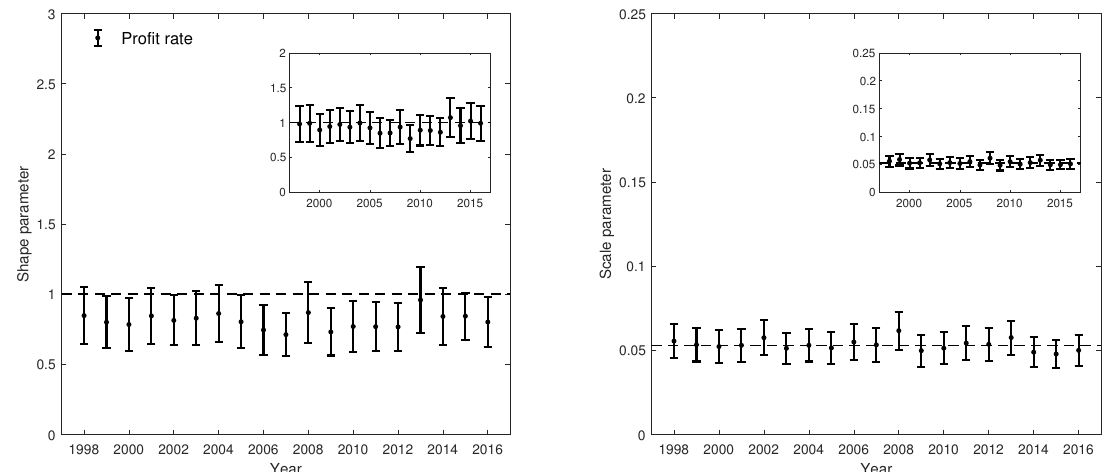
Figure 2. Estimates of the shape and scale parameter of the Subbotin distribution for profit rates. Error bars show two standard errors. The results refer to the 200 largest long-lived firms according to their sales in 2016. The dashed line in the scale parameter figure represents the median of the